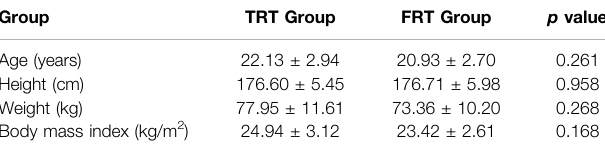
TABLE 1 | Group characteristics at baseline as Mean ±